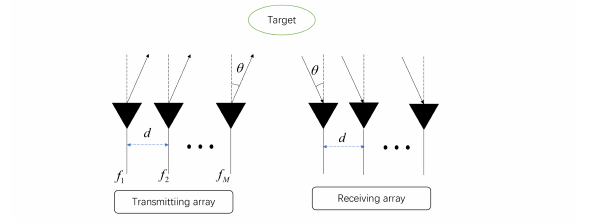
Figure 1. monostatic FDA-MIMO radar